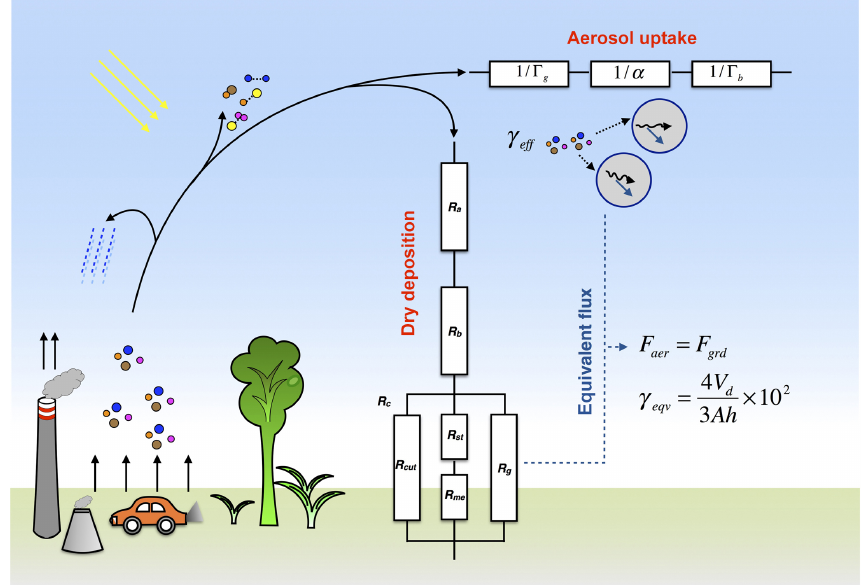
Figure 1. Schematic illustration of gas uptake on the ground and on aerosols in the planetary boundary layer as characterized by resistance models. The relative importance of aerosol uptake and dry deposition on the ground is characterized by comparing the aerosol uptake coefficient ( γ eff ) with an equivalent uptake coefficient ( γ eqv ) corresponding to the deposition velocity ( V d